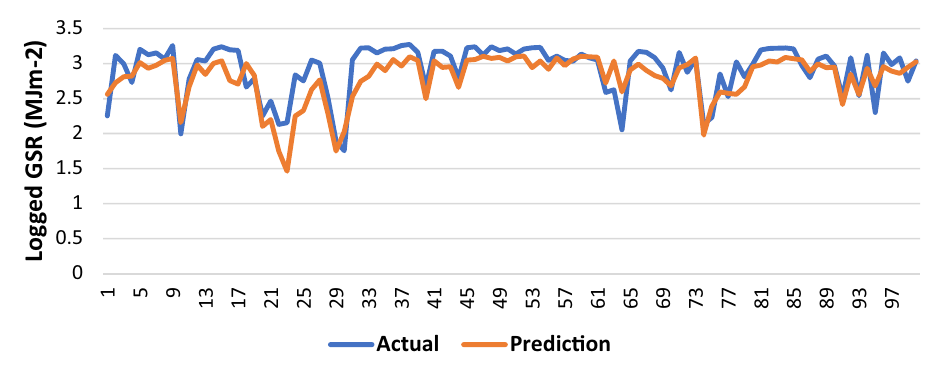
Figure 11. Graph of Actual and Predicted GSR (Model III—BR).